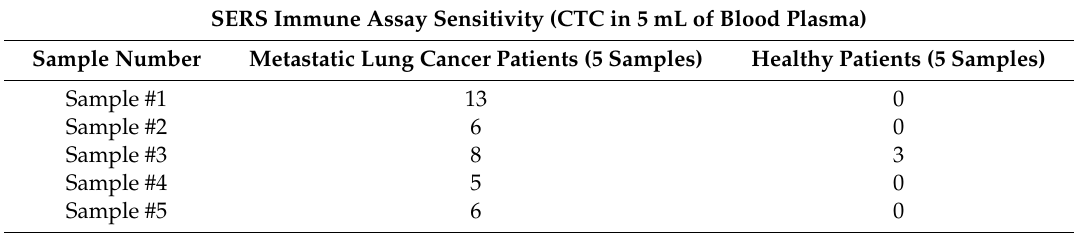
Figure 6. ( a ) SERS spectrum of the blood plasma of healthy volunteers ( n = 5) and ( b ) SERS spectrum of metastatic lung cancer patients ( n = 5) after applying the developed magnetically supported SERS-based immunoassay for the detection of circulating tumor cells. Table 2. Detection sensitivity of developed SERS immunoassay for clinical samples.